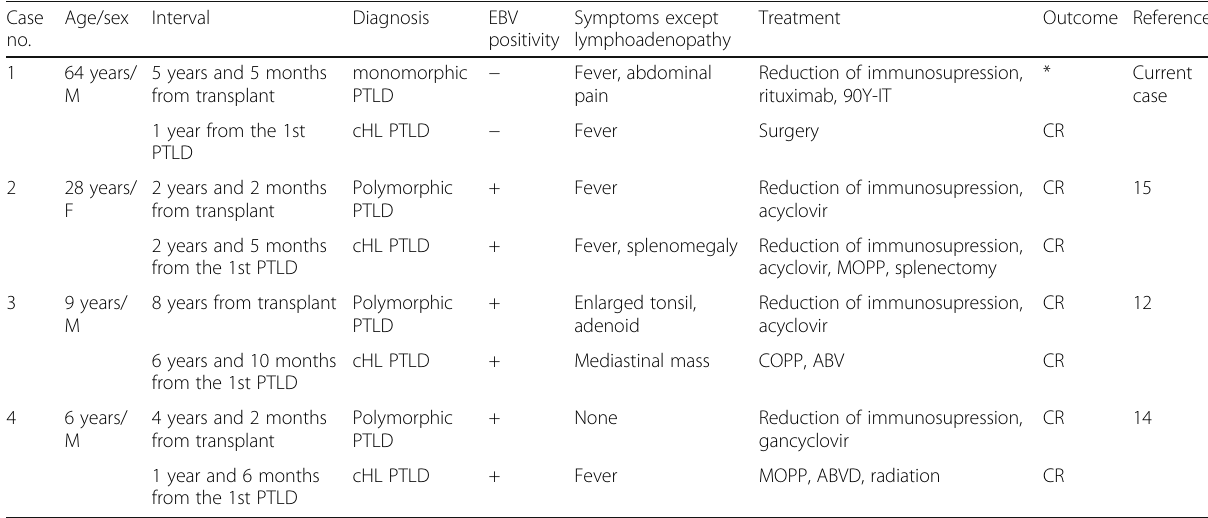
Table 2 Features of classical Hodgkin lymphoma (cHL)-type post-transplant lymphoproliferative disorder (PTLD) subsequent to another PTLD following liver transplantation Case